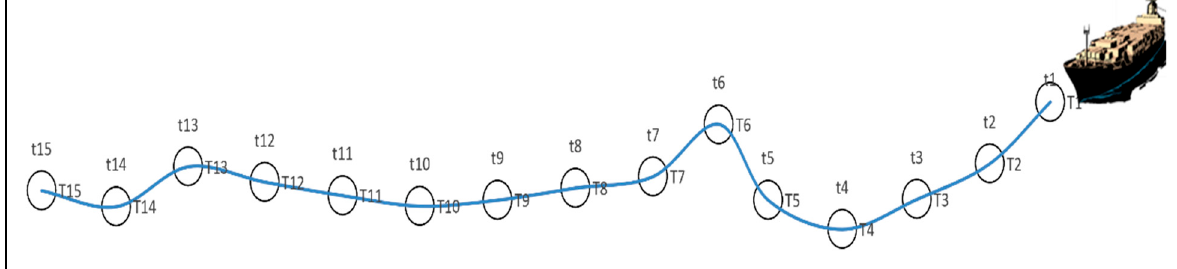
5 of 16 Figure 4. Ship interarrival ( left ) and arriving ( right ) time.